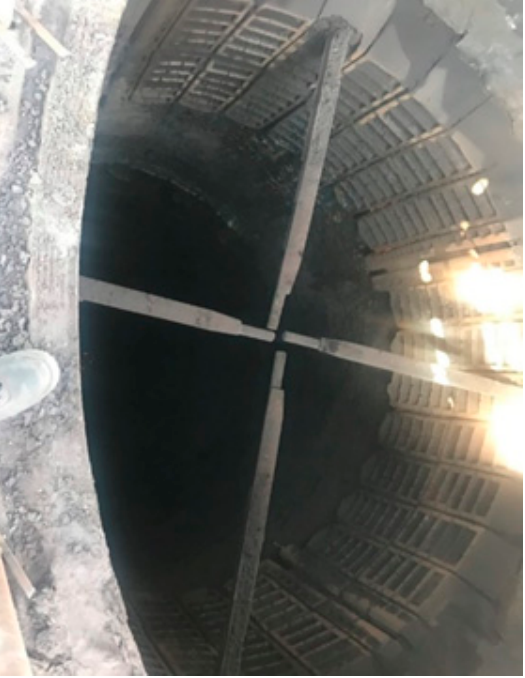
Figure 4. Location of thermal probes in BF No. 9 PJSC “Kamet-steel”.